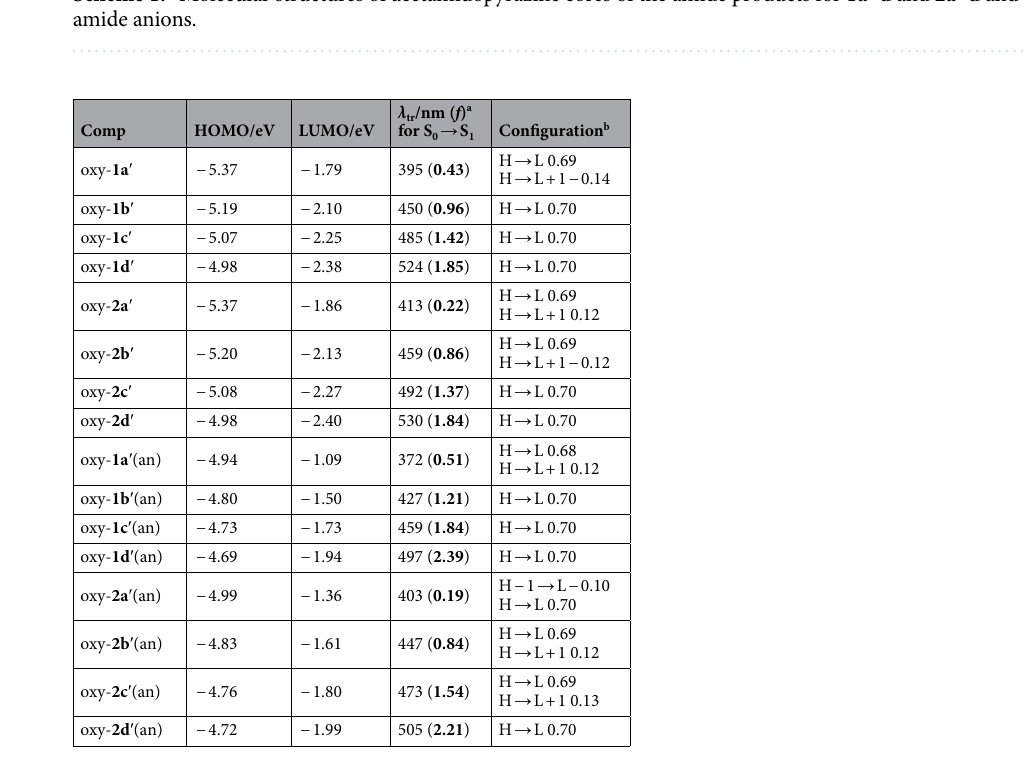
Table 2. Calculation data of acetamide cores oxy- 1a ′ – d ′ and oxy- 2a ′ – d ′ of the amide products from 1a – d and 2a – d and the corresponding amide anions with DFT and TD-DFT using B3LYP/6–31 + G(d) (IEF-PCM, DMSO). a Wavelengths ( λ tr ) estimated from the energies for S 0 → S 1 transitions. Oscillator strengths ( f ) are in parentheses. b H − 1, H, L and L + 1 denote the HOMO − 1, HOMO, LUMO and LUMO + 1, respectively. “an” means an anionic